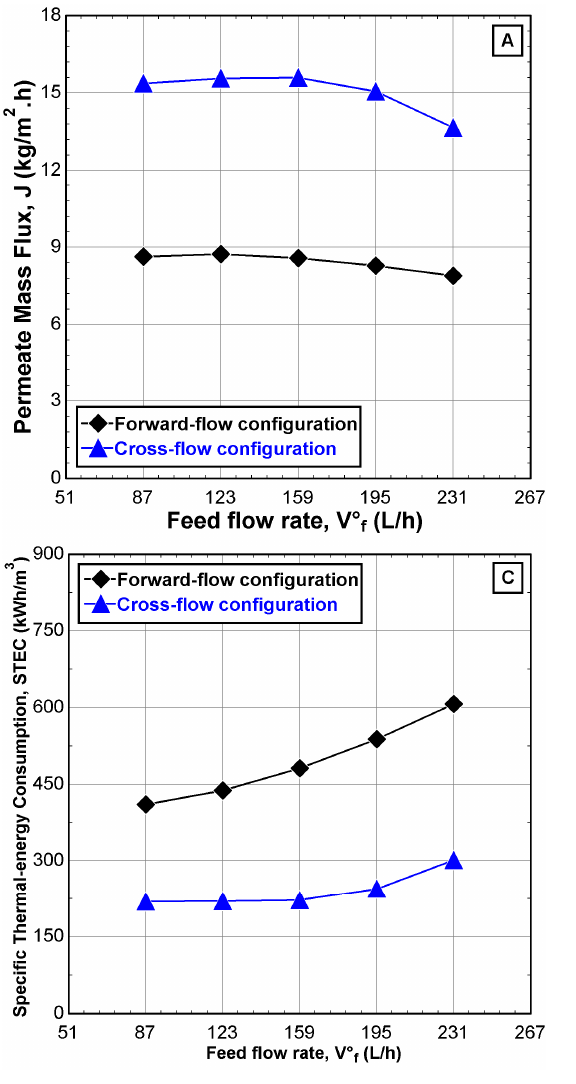
Figure 11. Effect of the feed water flow, 𝑣(cid:4662) (cid:3007)(cid:2871) on ( A ) permeate mass flux, ( B ) gain output ratio, ( C ) specific thermal energy consumption, and ( D ) specific electrical energy consumption for different feed-flow configurations ( 𝑣(cid:4662) (cid:3009)(cid:2869) = 900 l/h, T (cid:3009)(cid:2869) = 75 °C, 𝑣(cid:4662) (cid:3004)(cid:2869) = 405 l/h, T (cid:3004)(cid:2869) = 20 °C, 𝐶 (cid:3007)(cid:2871) = 1260 ppm, and 𝑃 (cid:3049) = 11.5 kPa).